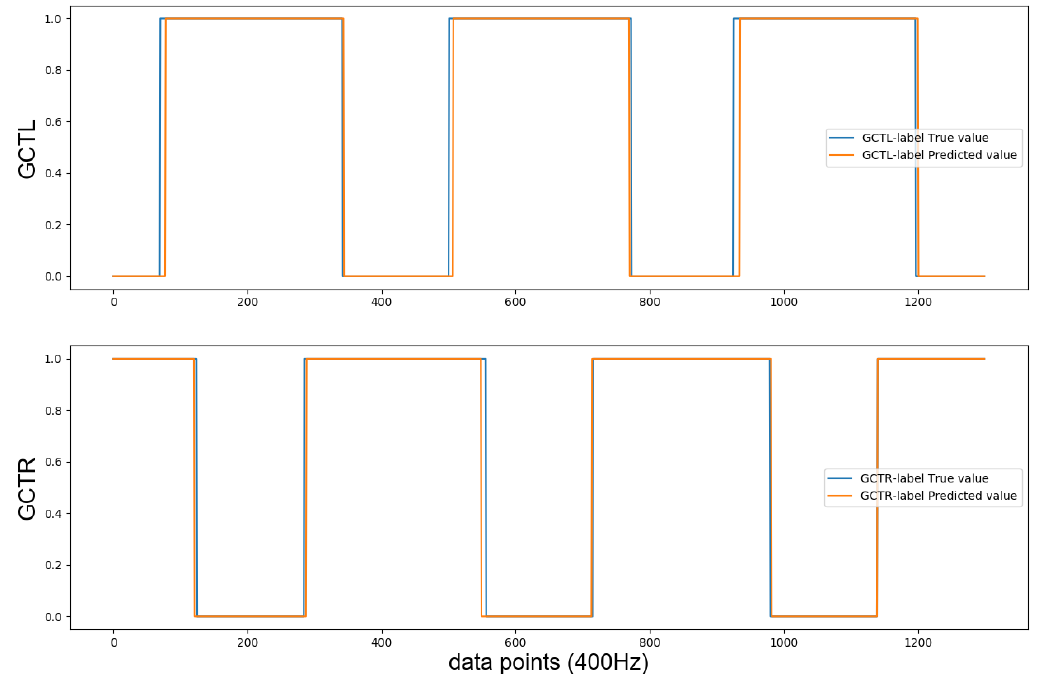
Figure 11. Glimpse of GCT label predictions for test set 1 (binary classifications obtained by applying threshold 0.5 to binary label